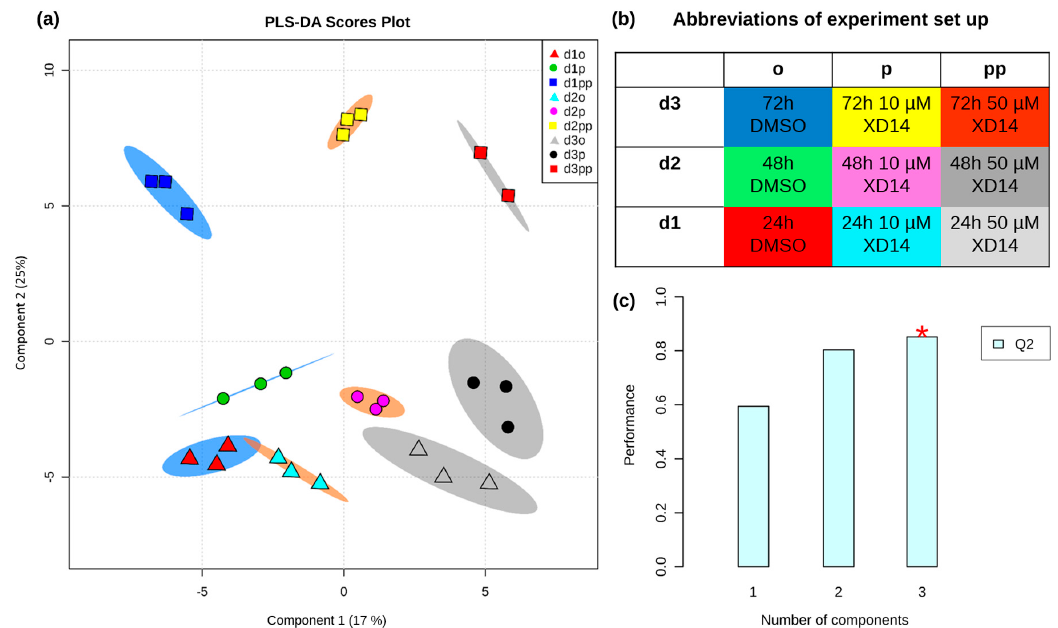
Figure 4. ( a ) Partial least squares discriminant analysis (PLS-DA) scores plot discriminates all samples based on time (day 1, 2, and 3 are in blue, orange, and grey shaded brackets, respectively) in component 1 and concentration (control, 10, and 50 µM XD14 treated groups are in triangle, circle, and square, respectively) in component 2. The explained variances of each group are shown in brackets; ( b ) Abbreviation of experiment setup; ( c ) Classification performance using different numbers of components, showing the explained variance in prediction Q 2 . The red asterisk indicates the best classifier.